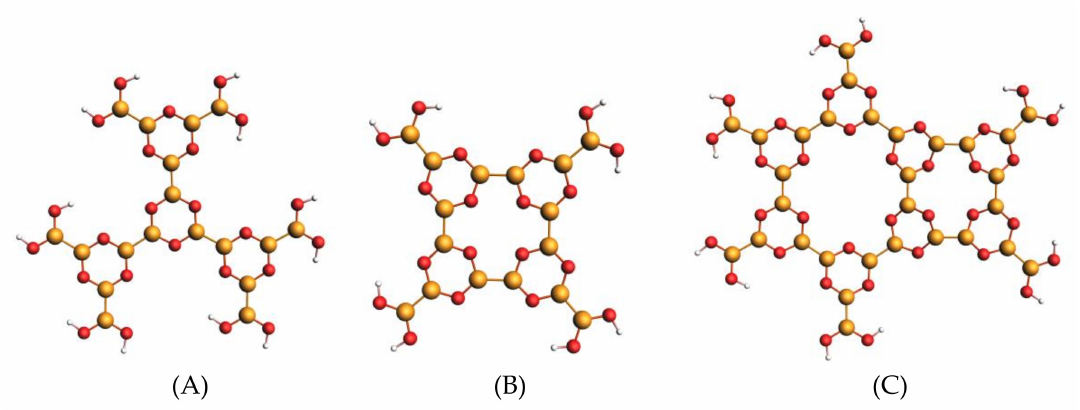
Figure 1. Ball-and-stick representation of the building blocks models of the THDB network: ( A ) model M1, portion of an ideal honeycomb boroxine network, ( B ) model M2, ( C ) model M3. B atoms in yellow, O atoms in red, H atoms in